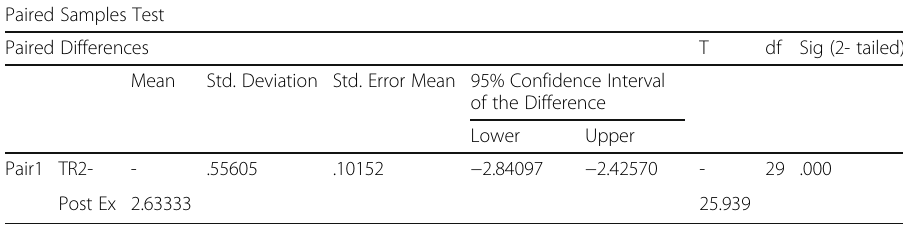
Table 18 Matched t -test between Post-Ex and TR2 Paired Samples Test Paired Differences Mean